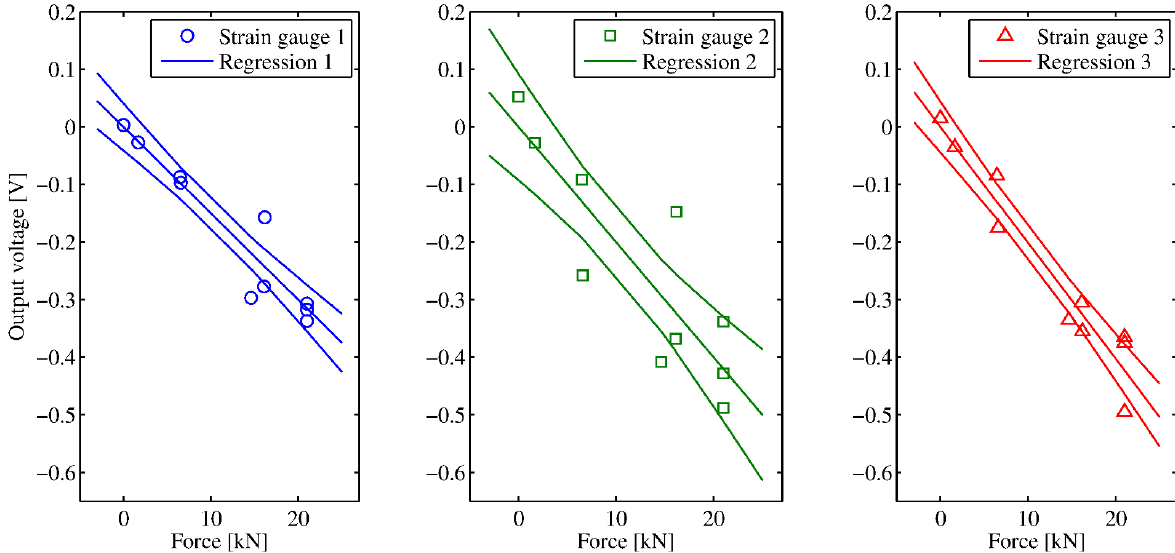
Figure 8. Calibration of the strain gauges. The graphs show the calibration lines for each strain gauge and their 95% confidence bands.